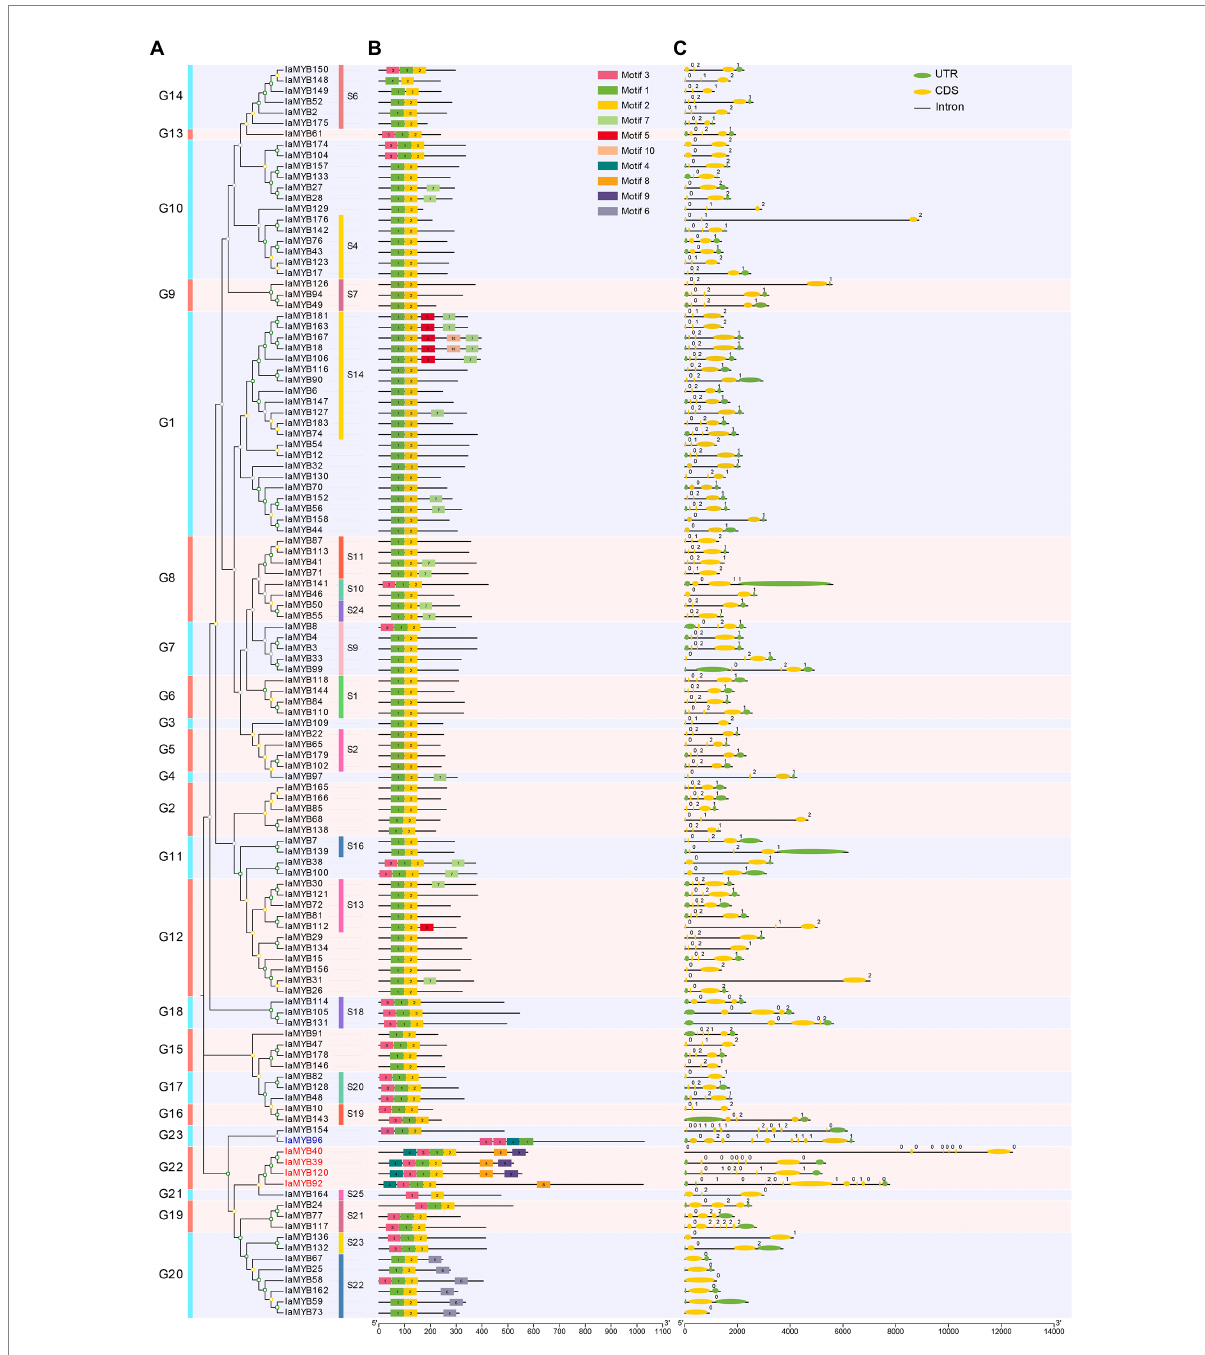
FIGURE 5 The phylogenetic tree, conserved motif, and exon-intron structures of the IaMYB genes. (A) The phylogenetic tree of the 117 IaMYB proteins (including 112 2R-type IaMYBs, four 3R-type IaMYBs, and one 4R-type IaMYB). (B) The conserved motif of the 117 IaMYB proteins. The rectangles with different colors represent the Motif 1–10; the black solid line represents non-conserved regions; the bar scale shows the length of the amino acids. (C) The exon-intron structures of the 117 IaMYB genes. The green ellipses represent the exons; the orange ellipses represent an untranslated region (UTR); the black solid lines among the ellipse represent the introns; the bar scale shows the length of the